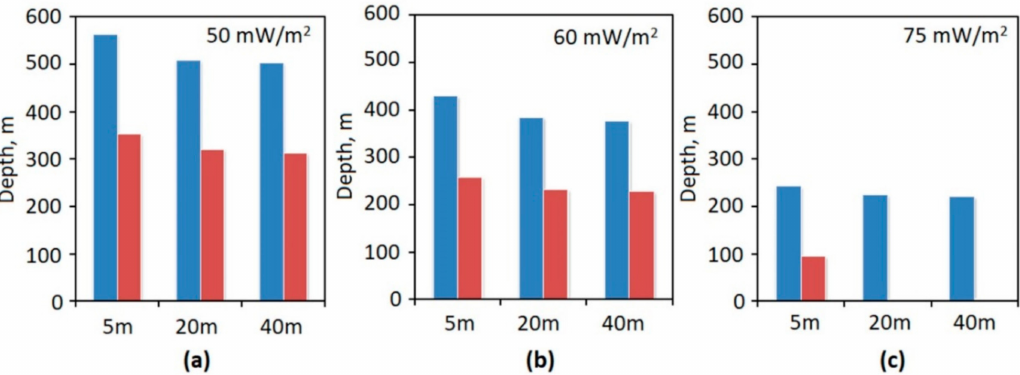
Figure 8. Shelf permafrost under the extraglacial (blue bars) and glacial conditions (red bars) on 5, 20, and 40 m isobaths. Modeling results for the recent period with the heat flux: ( a ) 50 mW / m 2 ; ( b ) 60 mW / m 2 ; ( c ) 75 mW / m